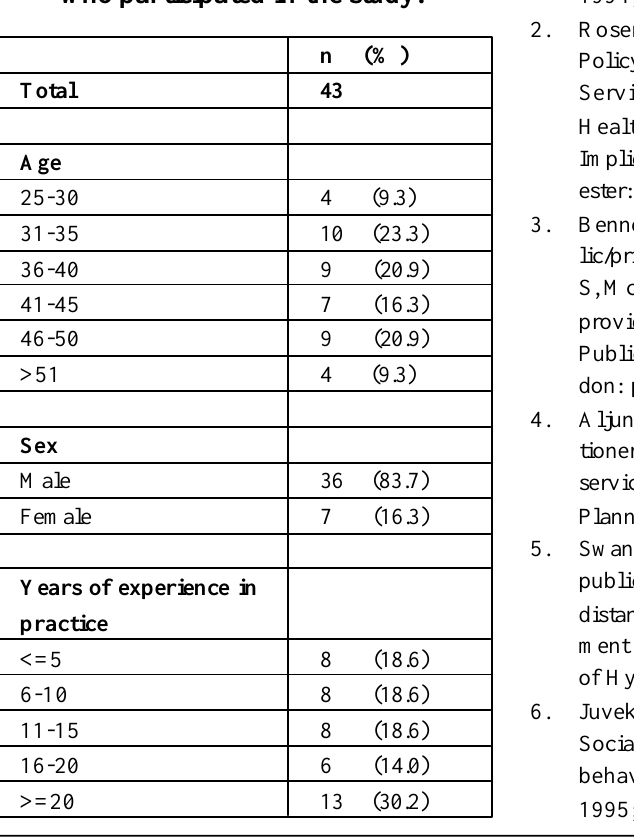
Characteristics of private practitioners who participated in the